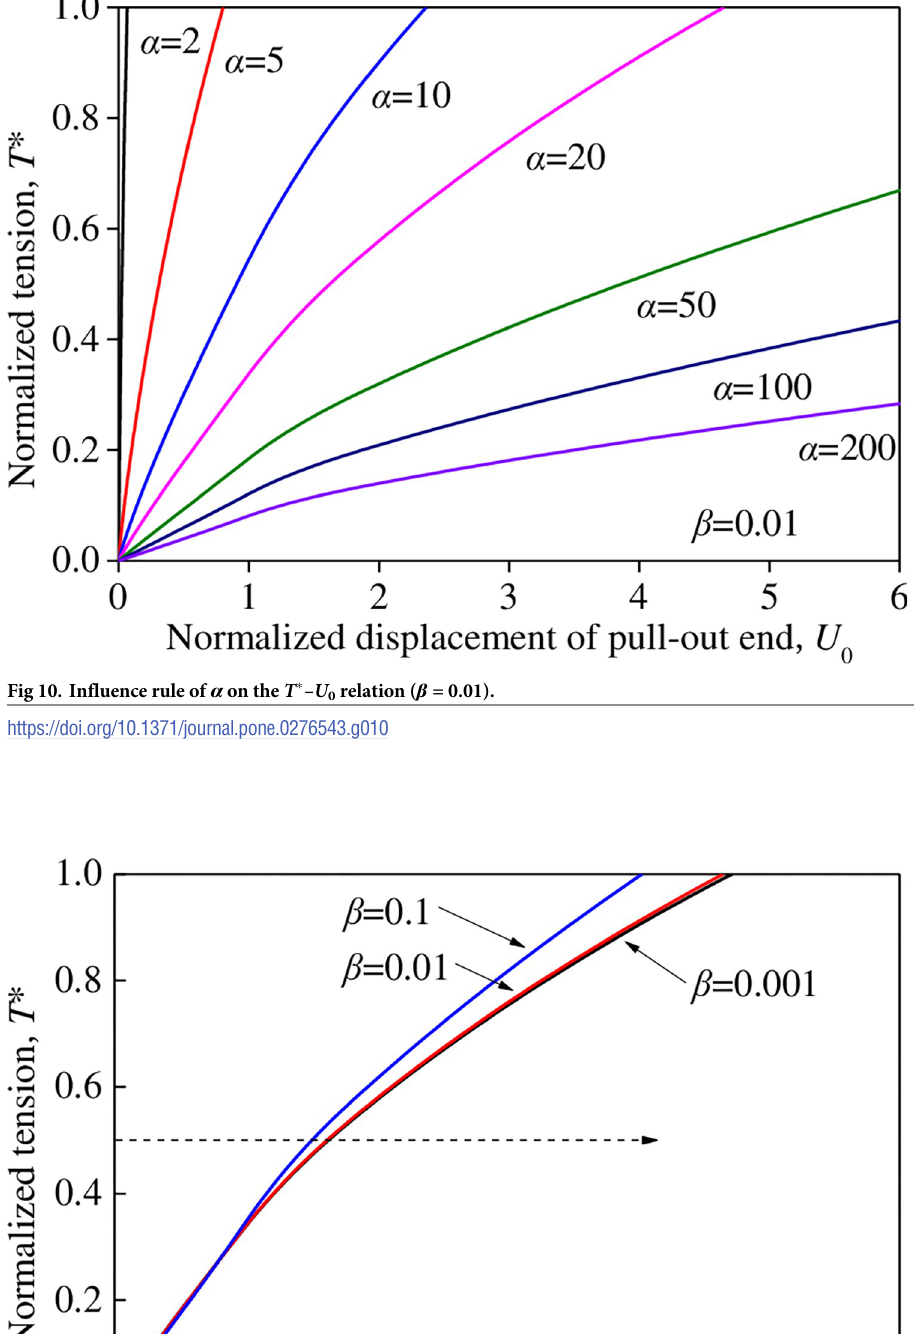
PLOS ONE | https://doi.org/10.1371/journal.pone.0276543 October 26,